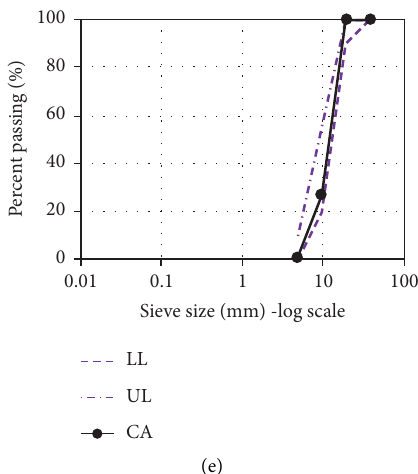
Figure 2: Gradation curves: (a) Lawrencepur sand, (b) Quarry dust, (c) Ravi sand, (d) Chenab sand, and (e) coarse aggregates (LL and UL � ASTM C33 lower limit and upper